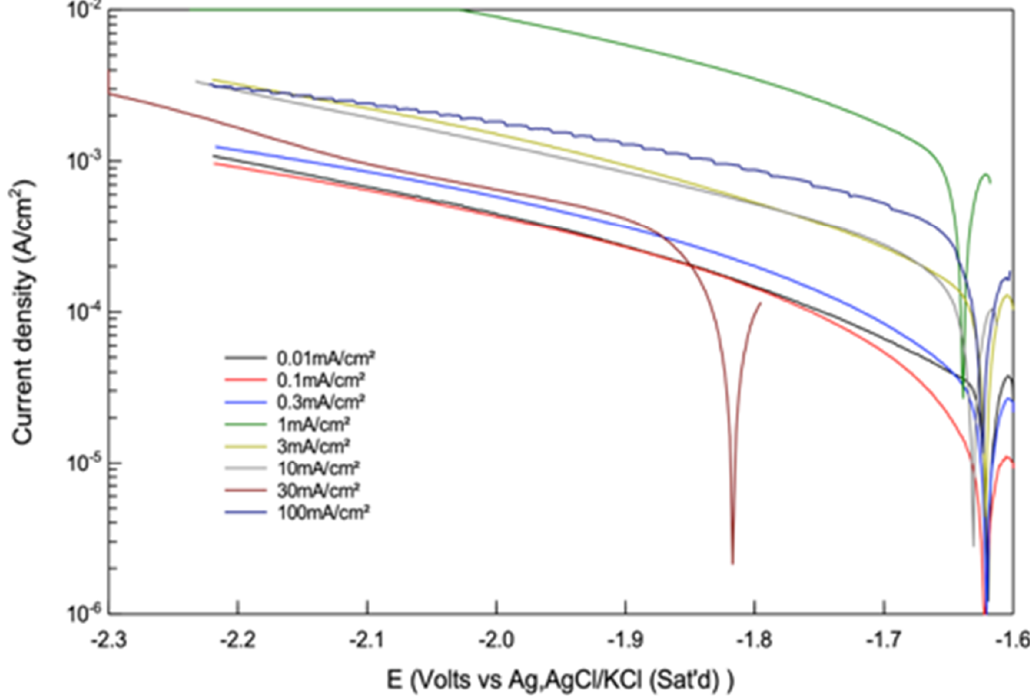
Figure 13. Typical cathodic polarization curves [92] for pure Mg and the Mg alloy WE43 measured immediately after the anodic polarizations. Extrapolation of each curve to the potential during the anodic polarization as presented in Figure 12 yielded the “enhanced” cathodic evolution rate corresponding to the anodic hydrogen evolution rate for that anodic polarization. This “enhanced” cathodic hydrogen evolution rate is plotted in Figure 14 to allow a direct comparison with the anodic hydrogen evolution rate. The enhanced catalytic evolution mechanism predicts that the “enhanced” cathodic hydrogen evolution rate must be equal to the anodic hydrogen evolution rate.